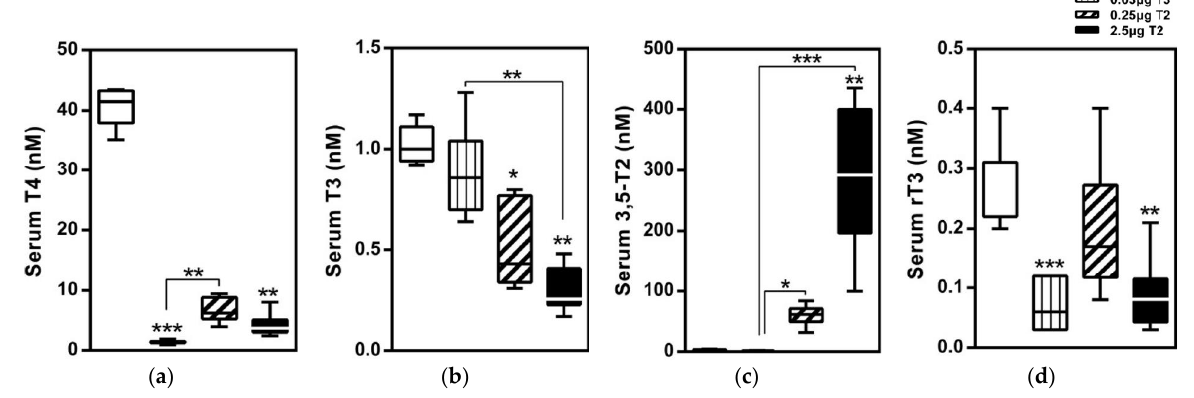
Figure 3. Serum TH profiles after a 14-day treatment with 3,5-T2 as measured by LC-MS/MS: Serum TH concentrations of HDF mice injected (i.p.) with either T3 (0.03 µg/g body weight) or 3,5-T2 (0.25 or 2.5 µg/g body weight) once daily at onset of dark cycle for 14 days to validate effects of 3,5-T2